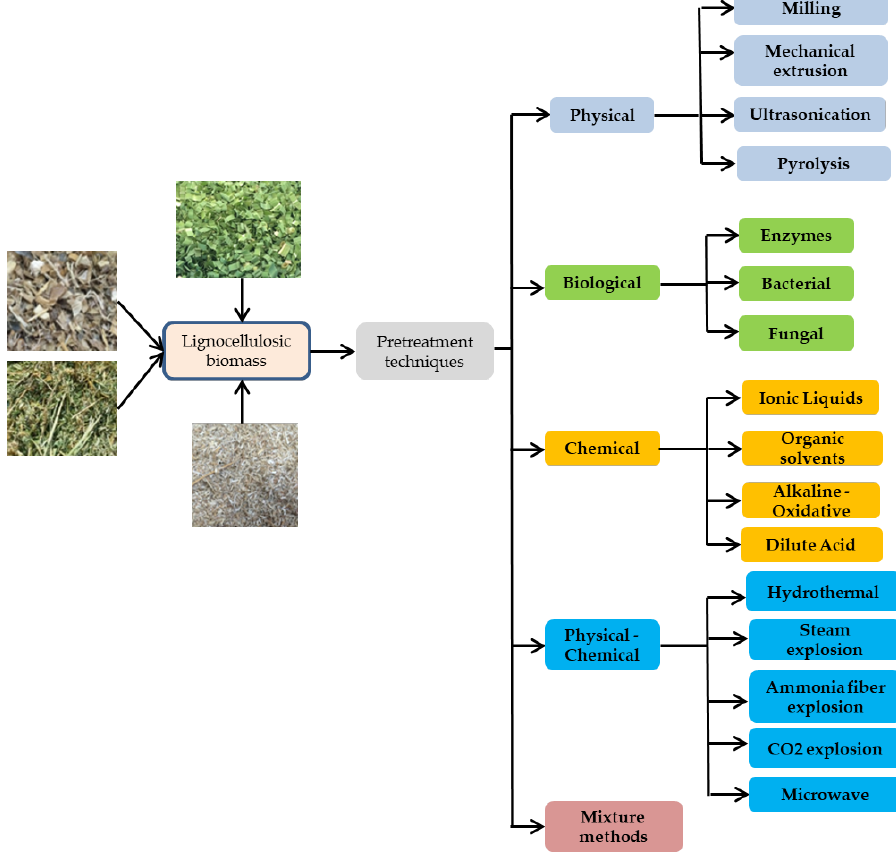
Figure 6 . Lignocellulosic biomass pretreatment techniques (based on [32–34]). Figure 6. Lignocellulosic biomass pretreatment techniques (based on